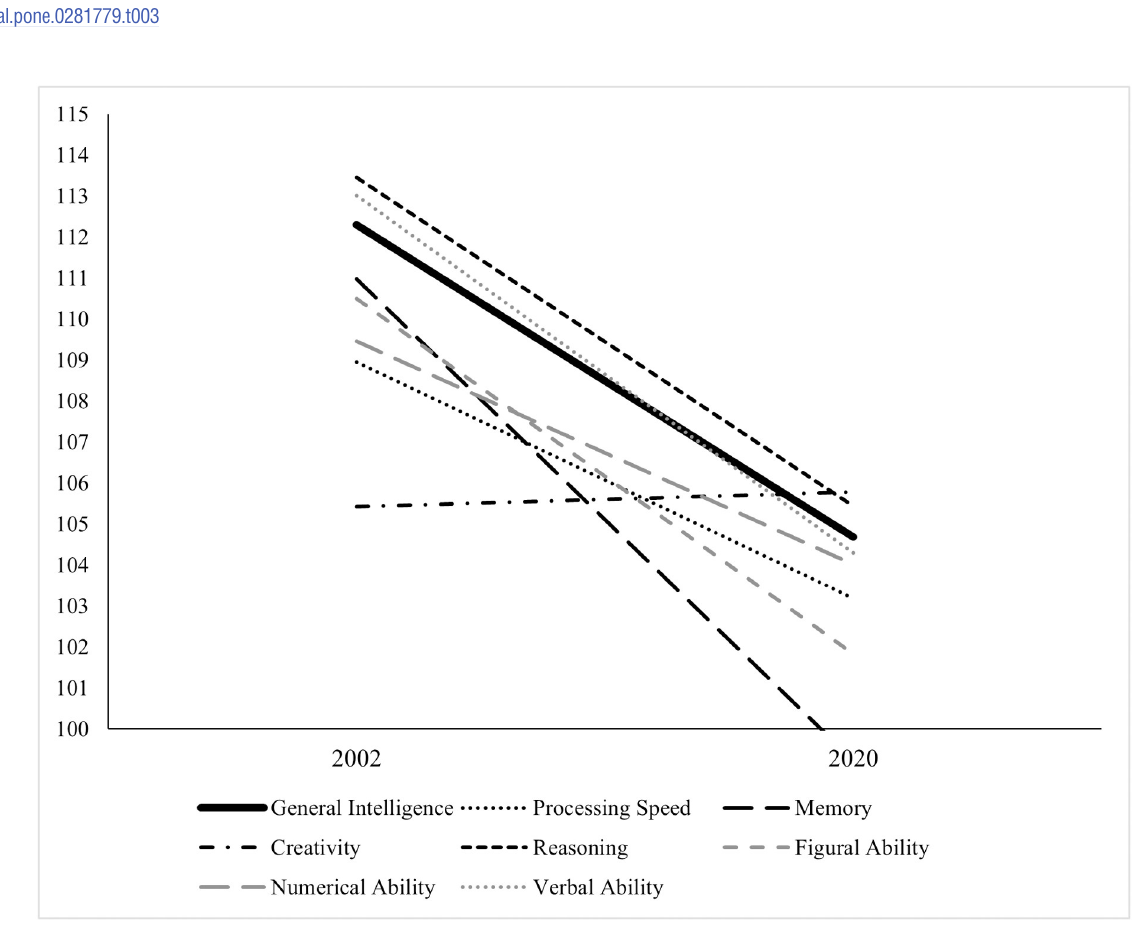
Fig 5. Mean IQs for the different ability scores in Analysis 1a.